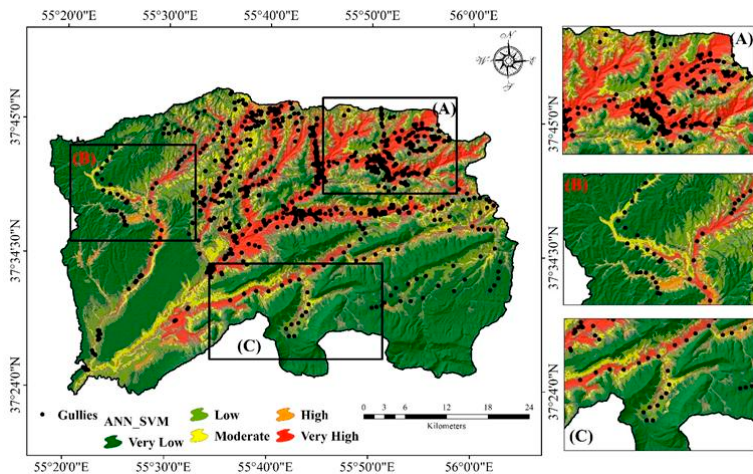
Figure 8. Gully erosion susceptibility mapping using the best model (ANN-SVM ensemble model). a, b, and c are zomed areas in the study area.